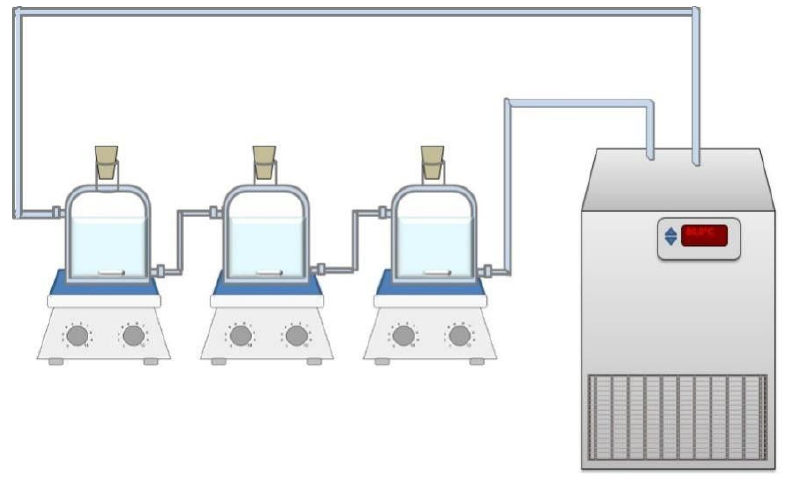
Figure 1. Integrated system: three reactors and thermostatic bath.